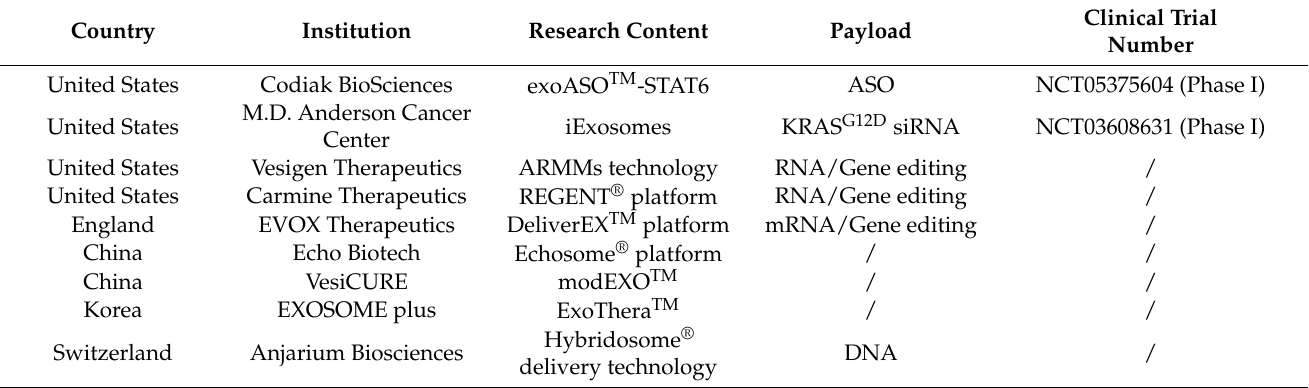
Table 3. A summary of clinical transformation of nucleic acid drugs based on EVs for cancer